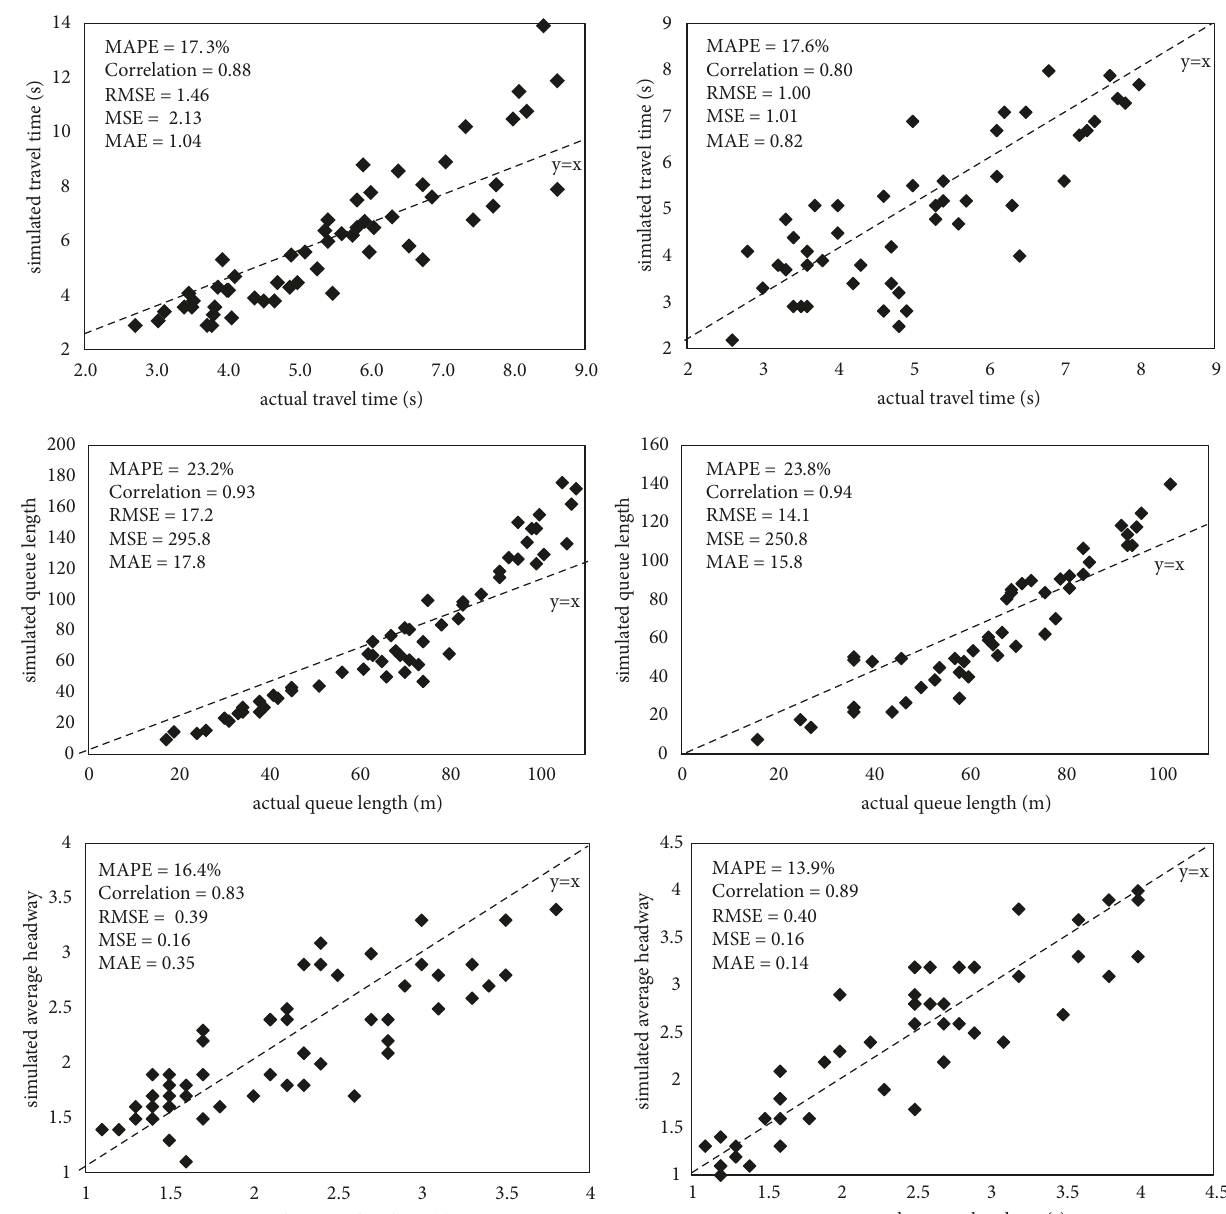
Figure 3: Simulated lane-based observations versus actual observations at each time interval at testing site (left) and validation site (right).